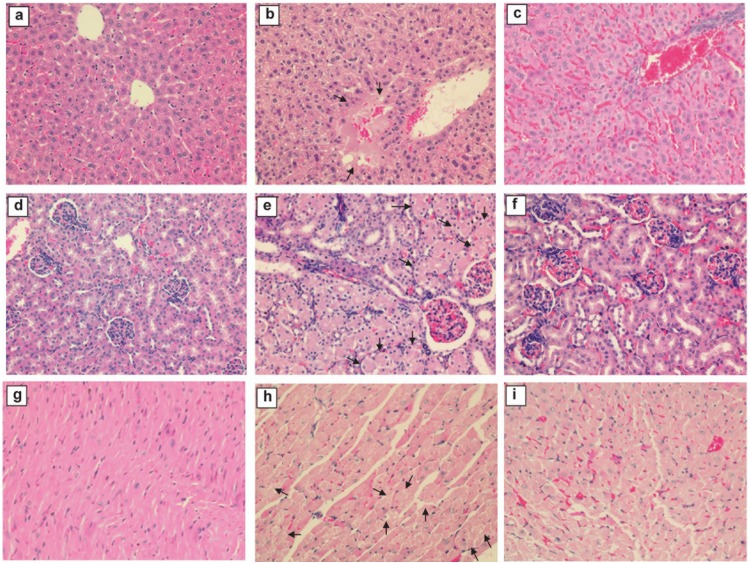
Liver, kidney and heart tissue degenerative changes in CK1-infected mice at day 6 post infection.Representative images of haematoxylin and eosin (H&E) stained tissue sections are presented. The liver (a), kidney (d), heart (g) of uninfected mice were shown for comparison. CK1-infected mice at day 6 p.i. showed liver hepatocytes degeneration, focal cells necrosis (arrows, b) and hemorrhagic changes (c); kidney tubular epithelial cells degenerative changes (arrows, e) and peritubular vessels congestion (f). Mild myocardial cell swelling (arrows, h) and red blood cells infiltrating between degenerative myocardial fibers (i) were seen in the heart. Original magnification ×200.